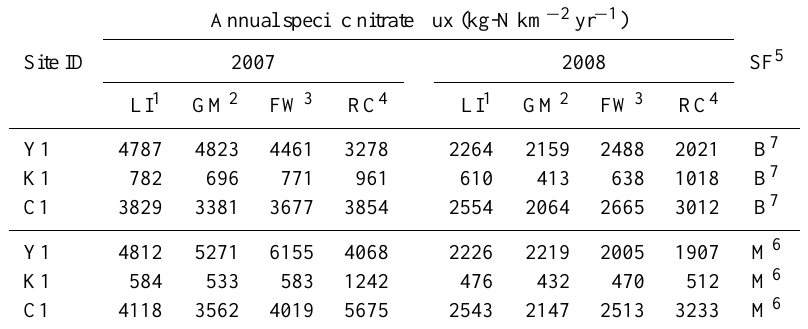
Table 6. The influences of monthly sampling and biweekly sampling schemes on estimating the observed NO 3 -N flux in the catchment